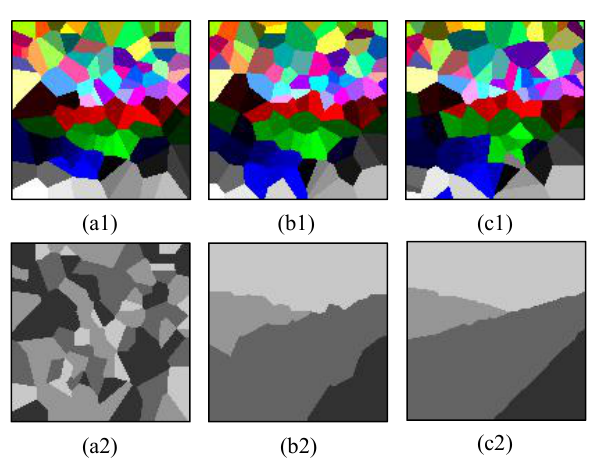
Figure 2. Segmentation results with initial state, 500 iterations and final result.